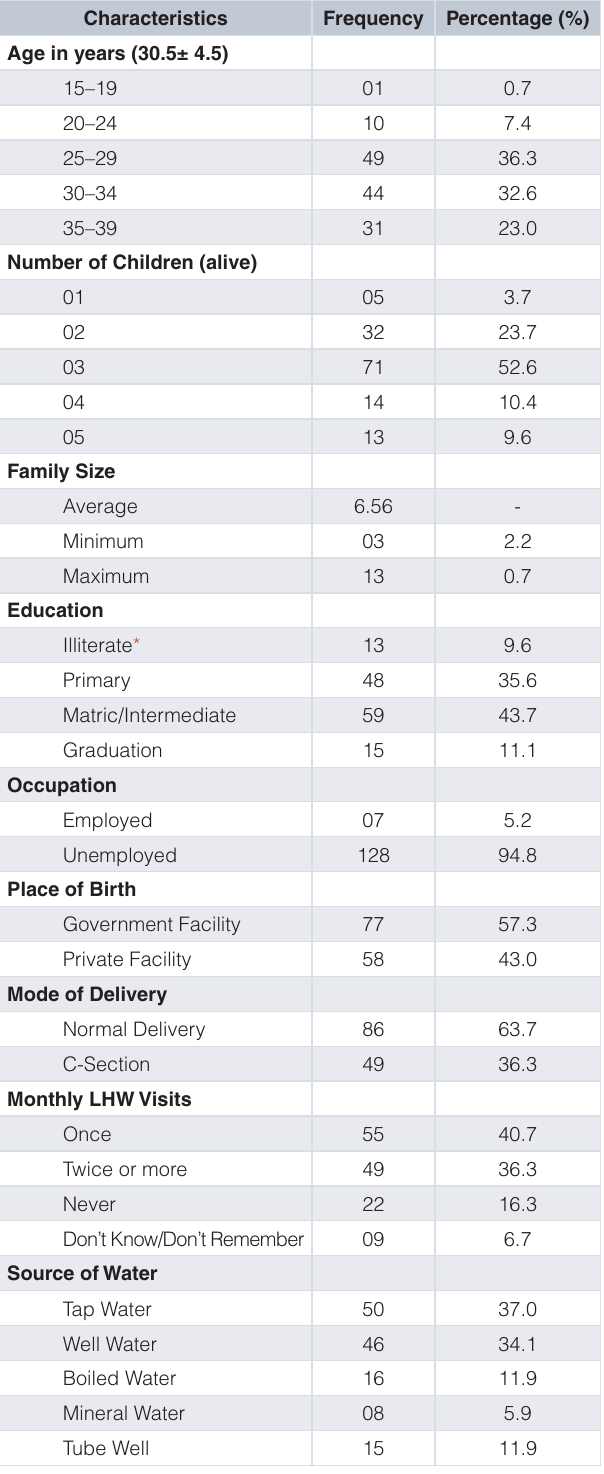
Table 1. Socio-Demographic characteristics of pregnant & lactating mothers in rural Islamabad, during 2016–2018